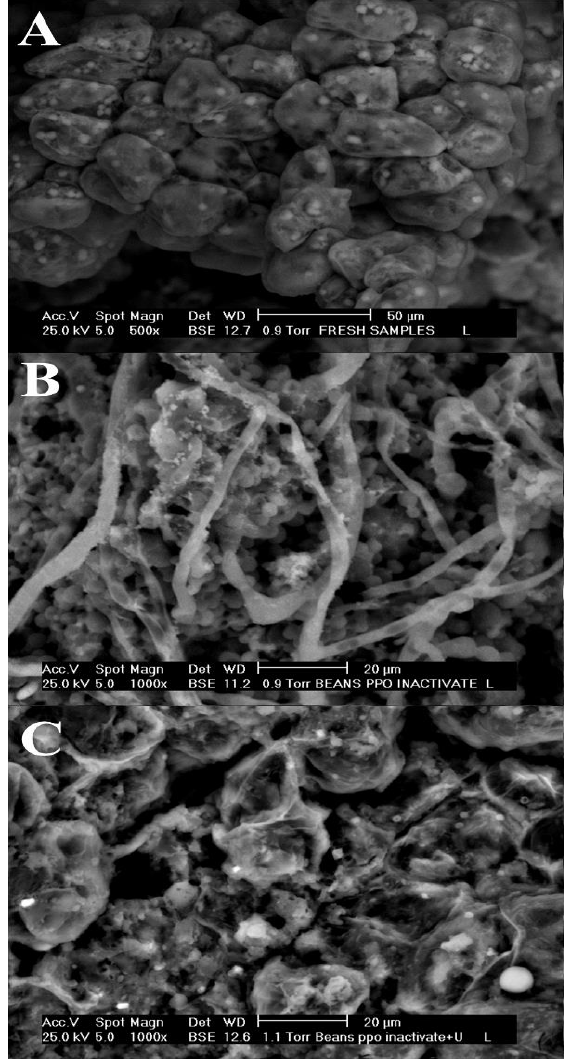
Figure 2. Microscopy images for the microstructure of ( a ) non-treated cocoa bean, ( b ) beans after PPO inhibition, and ( c ) beans after PPO inhibition and ultrasound treatment.